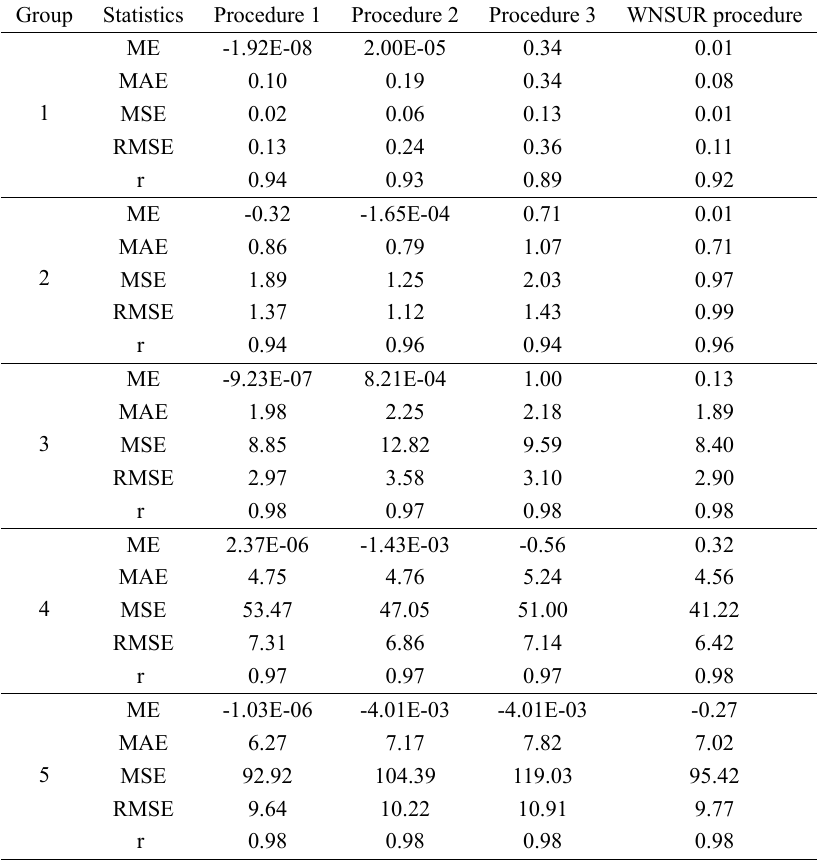
Figure 2 - Variation of the ratio between the biomass of the components and the total biomass with the stem volume in stands of black wattle in the state of Rio Grande do Sul, Brazil. Statistics obtained for comparison the estimates trough ratio and WNSUR procedures of stem biomass in stands of black wattle in the state of Rio Grande do Sul,